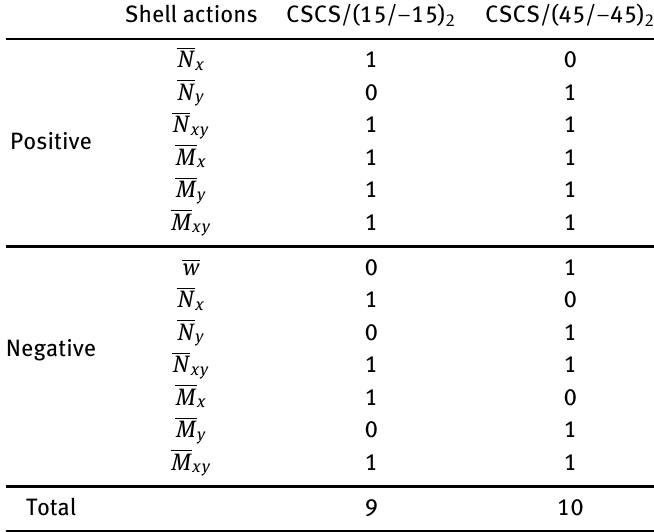
Table 18: Relative performance matrix considering CSCS/(15/ − 15) 2